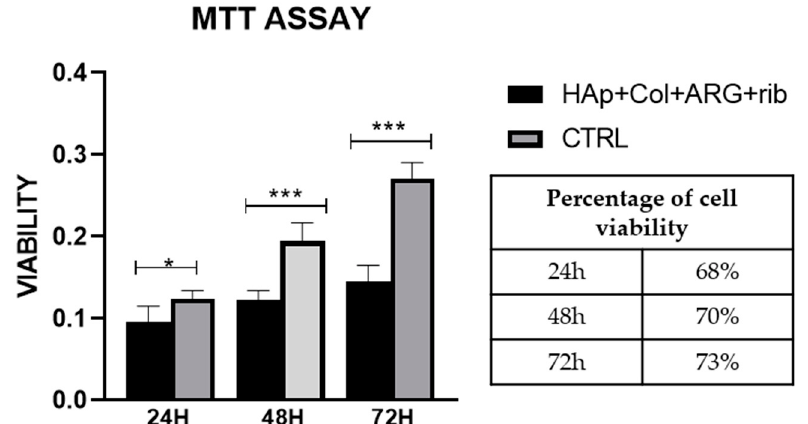
Figure 10. MTT assay on HAp-Col-Arg scaffolds crosslinked with 0.01% riboflavin. Comparison is